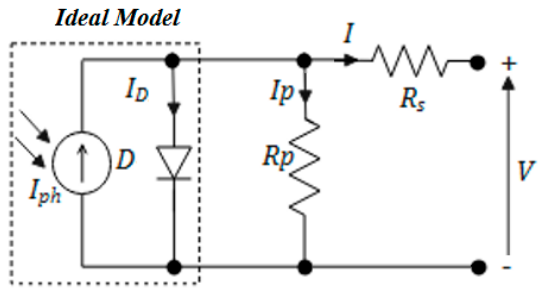
Figure 2. Simplified equivalent circuit of solar cell.